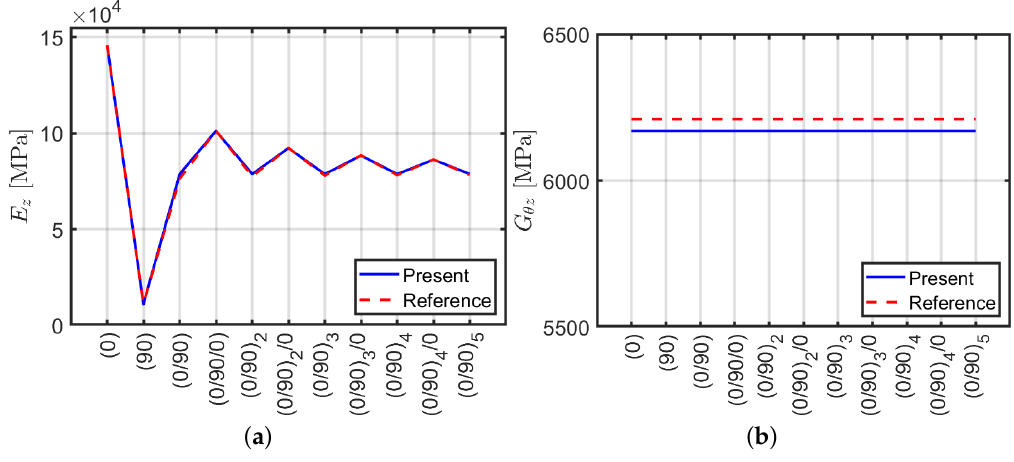
Figure 3. Equivalent moduli using ABAQUS and Sun et al. [40] approach: ( a ) normal E z ; ( b ) shear G θ z